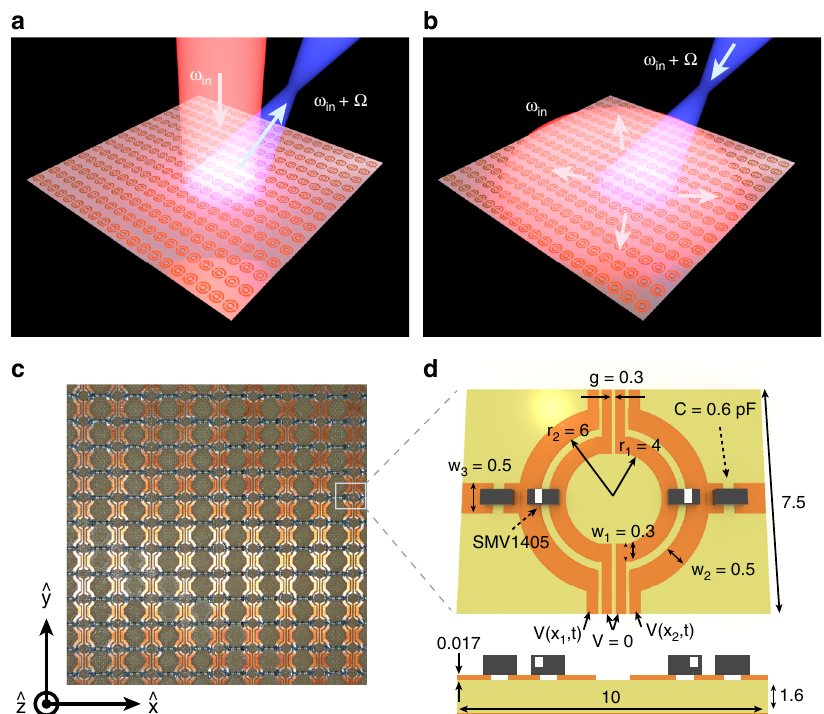
Fig. 1 Spatio-temporally modulated metasurfaces. a An incident beam impinging on an STMM is converted into a different frequency harmonic that can be focused at any desired focal point. b Breakdown of Lorentz reciprocity can be shown by probing the time-reversed process. c Photograph of our STMM. d Top view and cross-section of the unit cell. All geometrical parameters are in